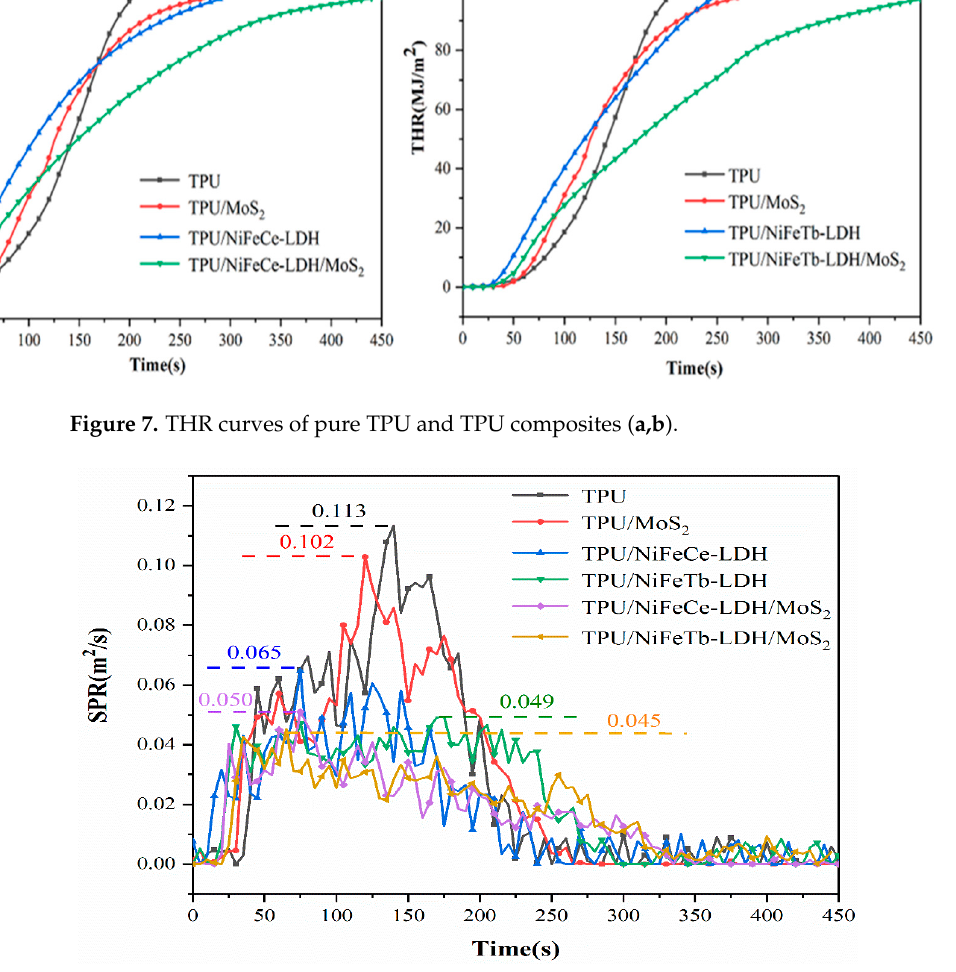
Figure 8. SPR curves of pure TPU and TPU composites.